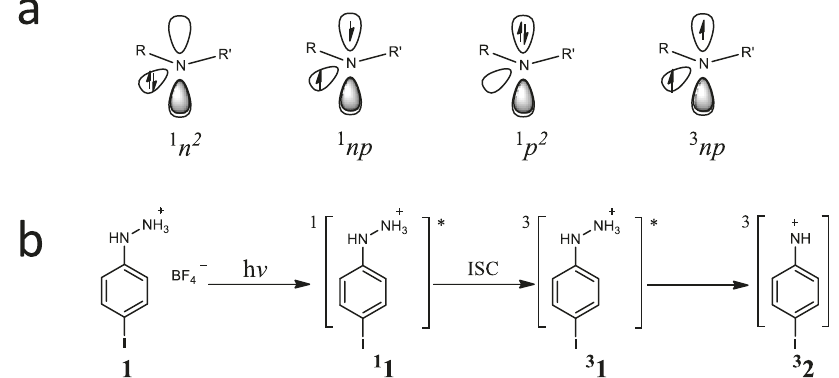
Fig. 1 Introduction of the nitrenium ions. a Electronic con fi gurations of nitrenium ions: a closed-shell singlet state ( 1 n 2 ), an open-shell singlet state ( 1 np ), a second closed-shell singlet state ( 1 p 2 ), and an open-shell triplet state ( 3 np ), ( b ) proposed mechanism for the generation of triplet phenylnitrenium ion 3 2 ( np ): after excitation, the singlet excited state of 1 1 could go through the intersystem crossing (ISC) process to produce the triplet excited state of 3 1 , which could generate the triplet nitrenium ion 3 2 through the N – N bond